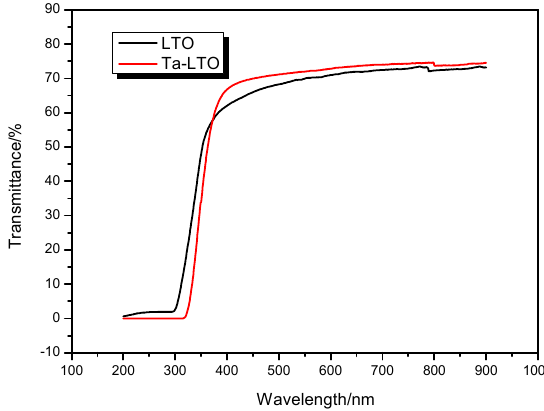
Figure 6. Transmission spectrum of Ta-LTO and LTO single crystals (0.02 mm).